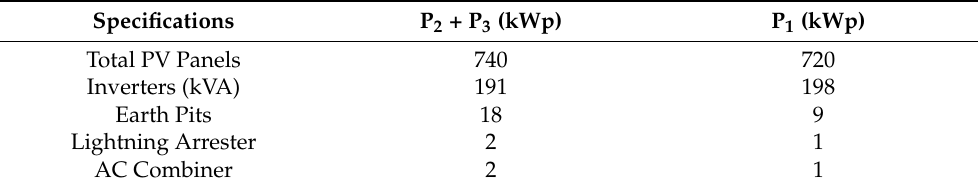
2 + P 3 ’ and Plant ‘P 1 ’ .